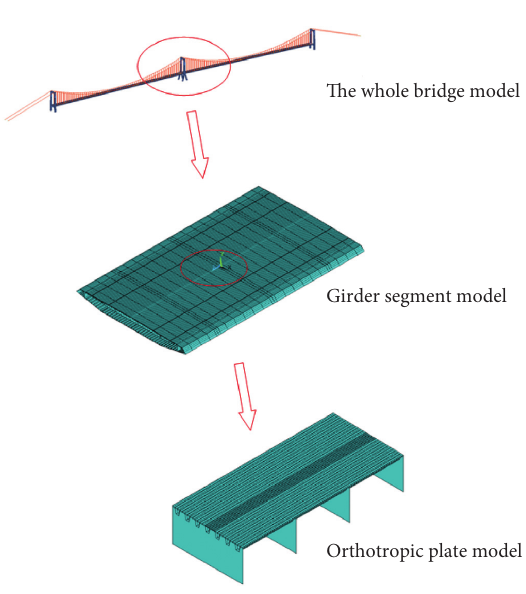
Figure 2: Schematic diagram of the three-stage analysis